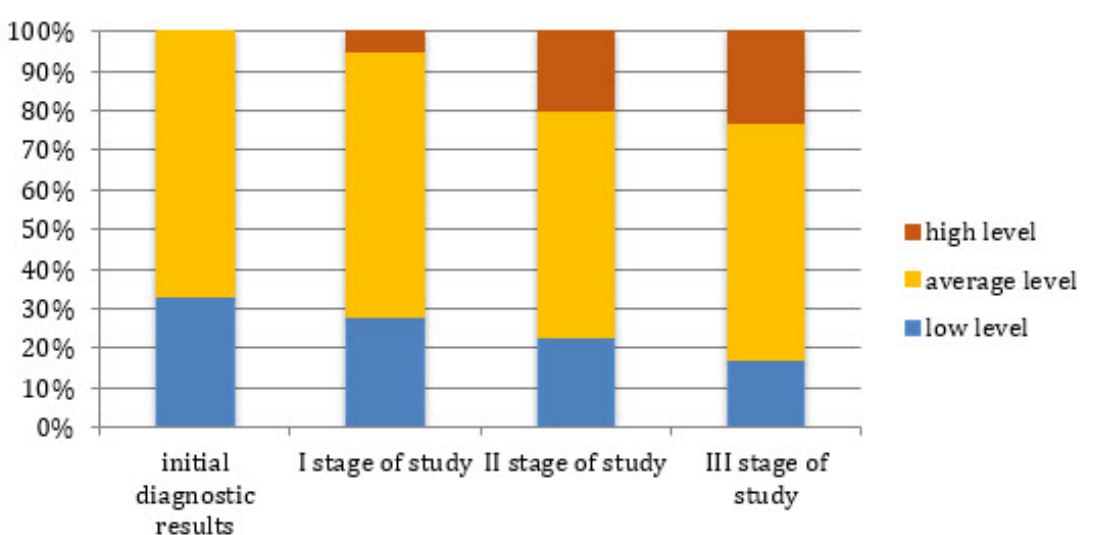
Figure 2. State of competency of the investigated phenomenon in experimental group (N=19, in